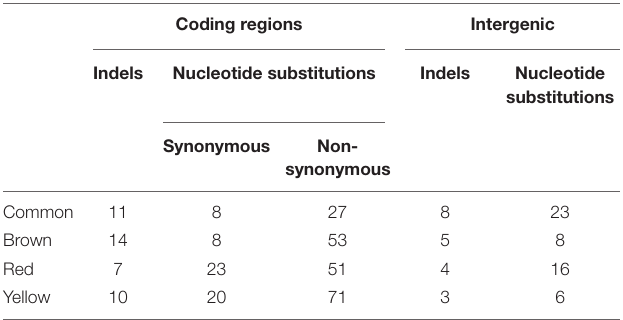
TABLE 1 | Genetic events present in all three pigmented variants, the brown pigmented variant alone, the red pigmented variant alone, and the yellow pigmented variant